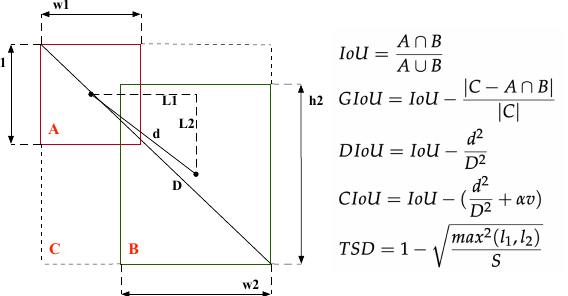
Figure 1. The graphical description of different metrics. Box A denotes the ground truth; box B denotes the predicted bounding box. v = 4